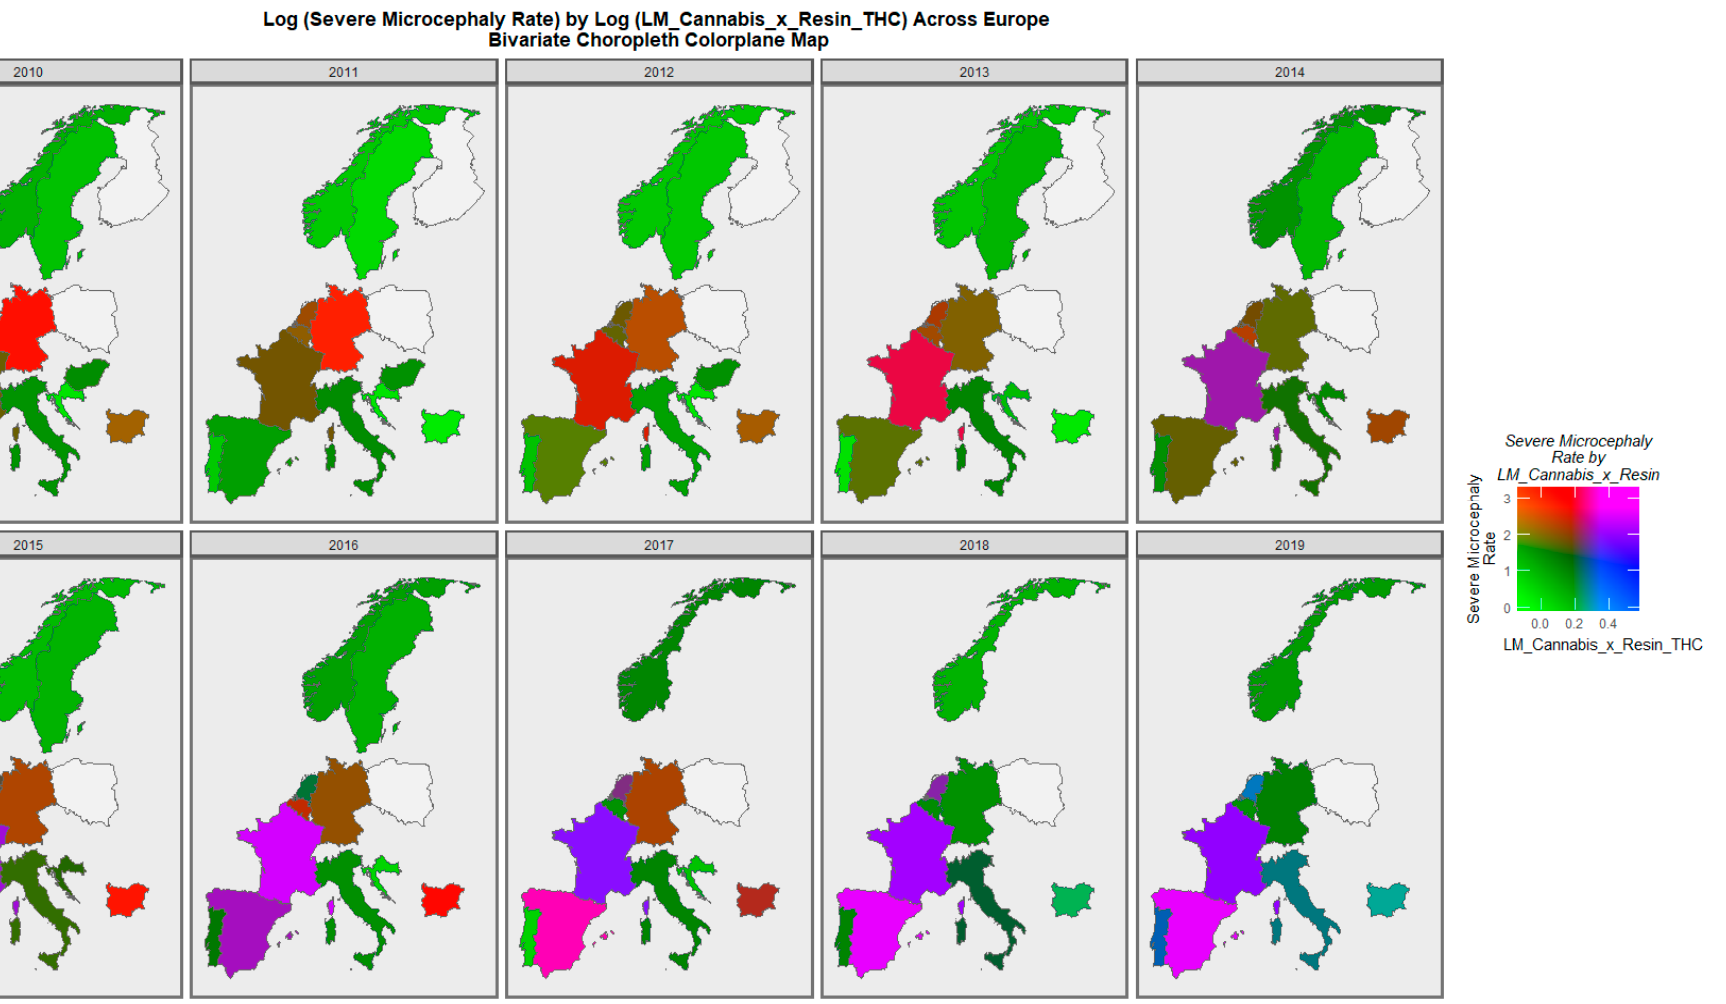
Figure 7. Bivariate colorplaner sequential map-graphs of log (severe microcephaly rates) by log of last month cannabis use: cannabis resin THC concentration across surveyed European nations over time, 2010–2019.